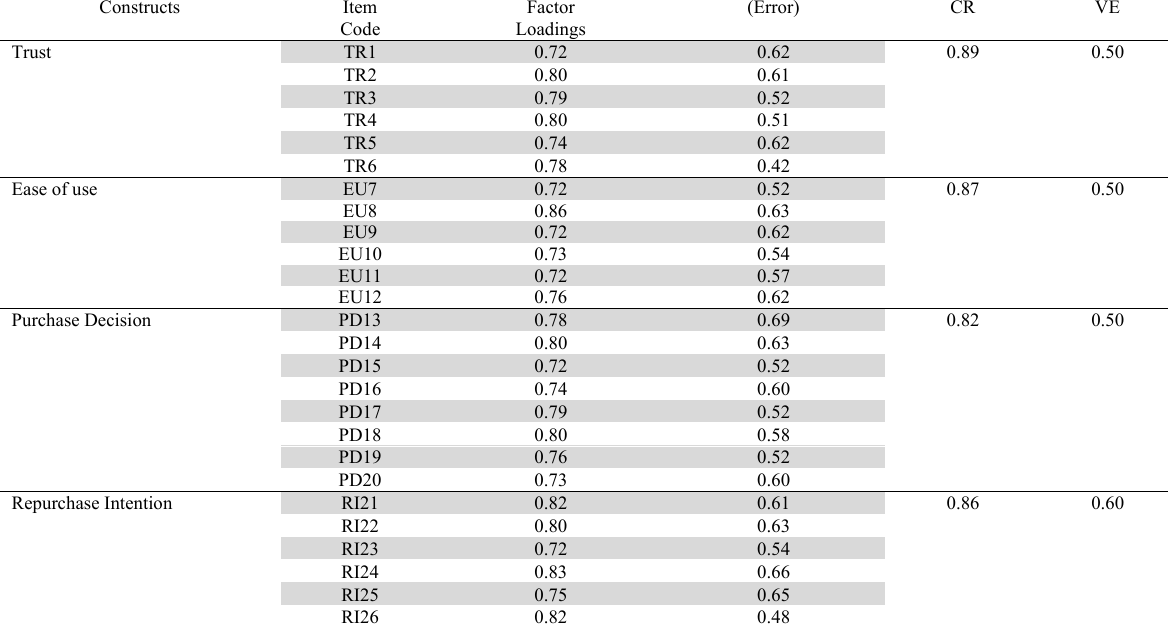
Construct reliability and variance extracted